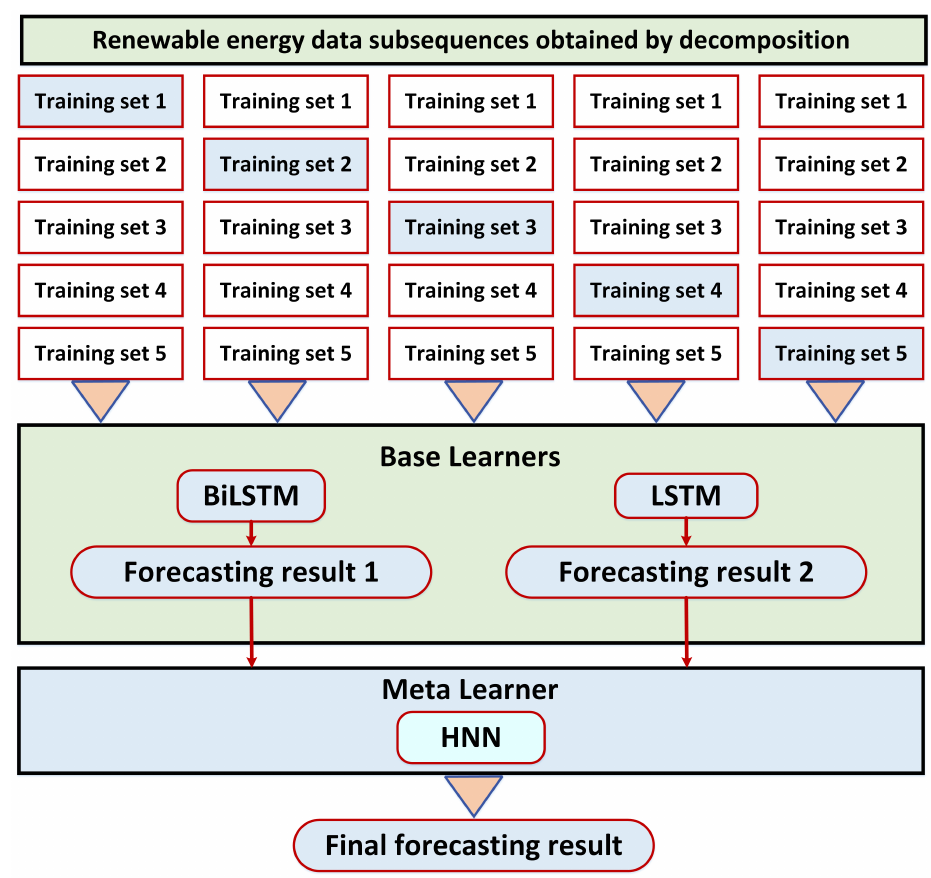
Figure 5. Architecture of the proposed renewable energy prediction